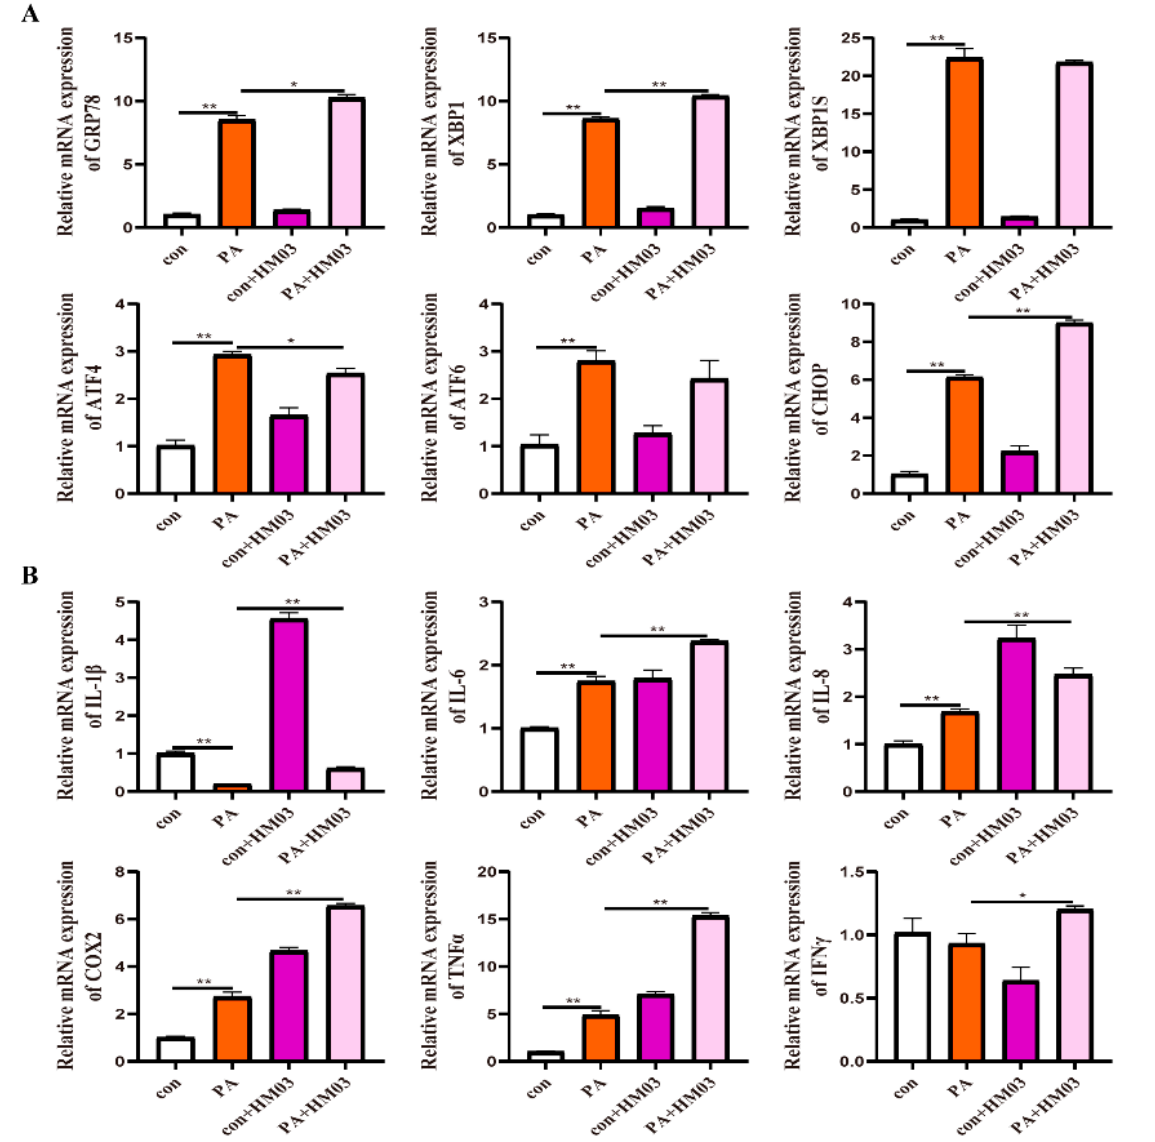
Figure 11. Effects of 10 µ M HM03 treatment for 4 h before 500 µ M PA incubation for 6 h on ER stress and inflammation in macrophages of large yellow croakers. ( A ) Relative mRNA expression of ER stress-related genes. ( B ) Relative mRNA expression of inflammatory genes. Values are presented as mean ± SEM ( n = 3). * Significant difference ( p < 0.05); ** highly significant difference ( p < 0.01).